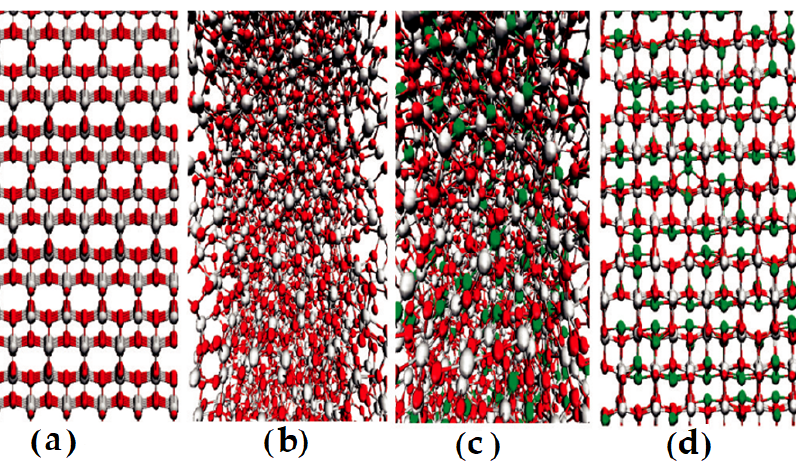
Figure 12. Structures containing 4320 atoms used in the simulations for ( a ) TiO 2 anatase, ( b ) TiO 2 608 amorphous, ( c ) 50% Li-loaded amorphous, and ( d ) 50% Li-loaded anatase. Red, gray, and green spheres represent oxygen, titanium, and lithium, respectively. Reprinted with permission from Ref. [169]. Copyright © 2011, American Chemical